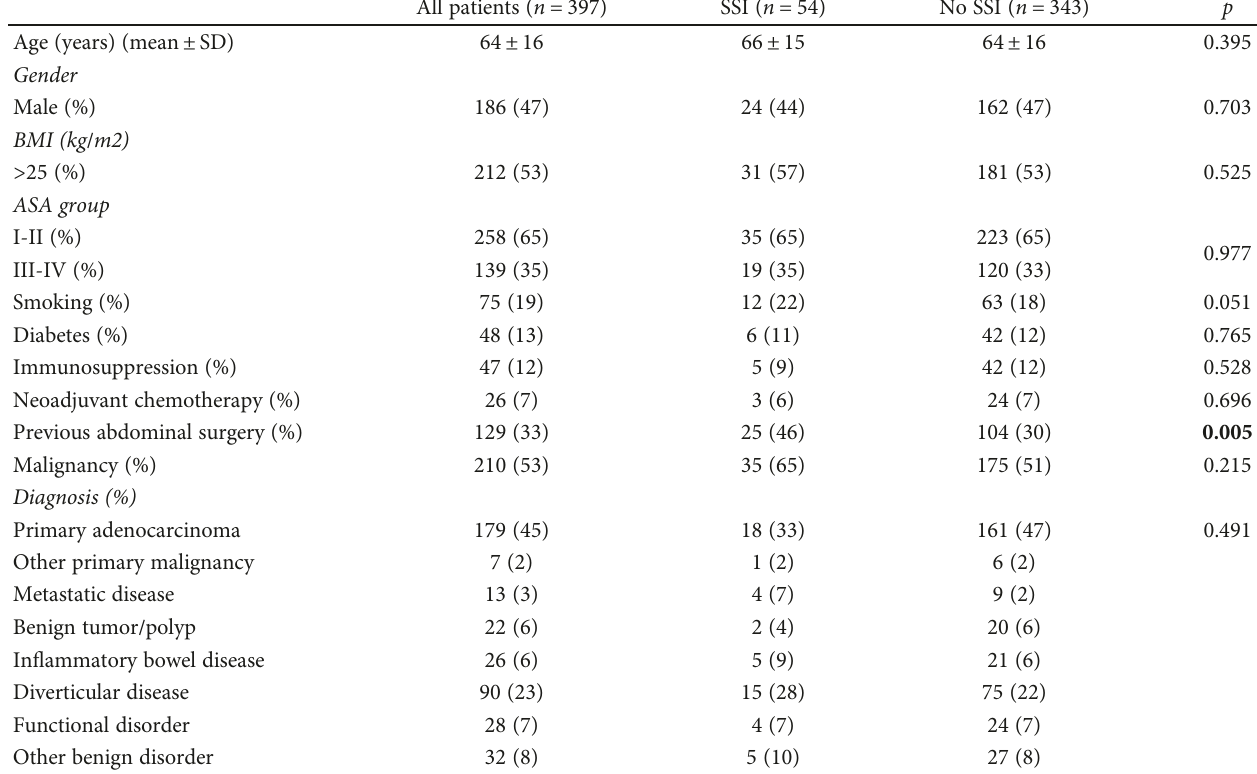
Table 1: Baseline